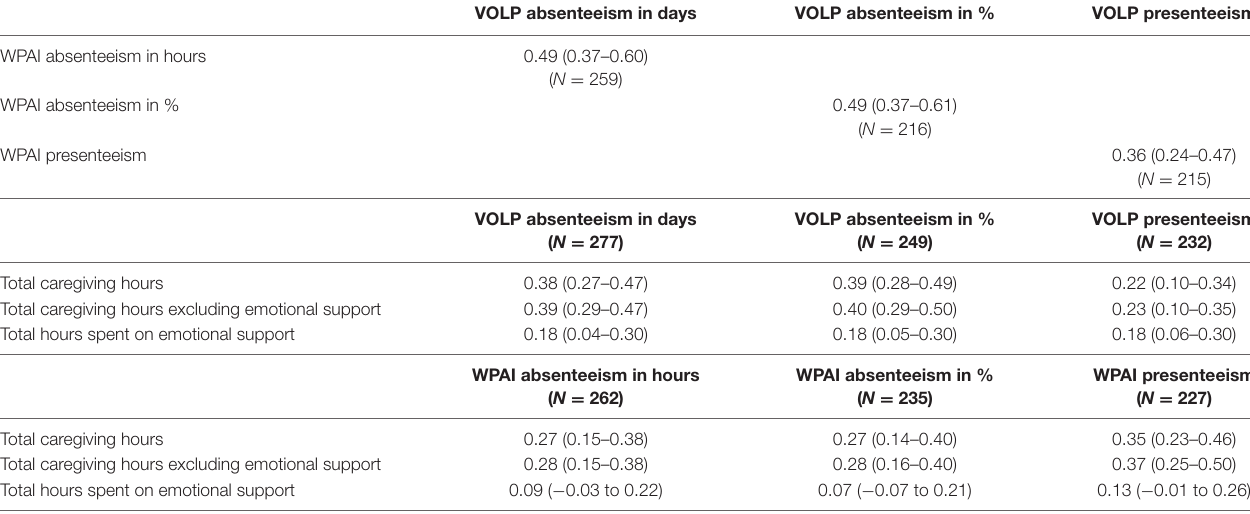
TABLE 3 | Spearman correlations between VOLP outcomes, WPAI outcomes and caregiving